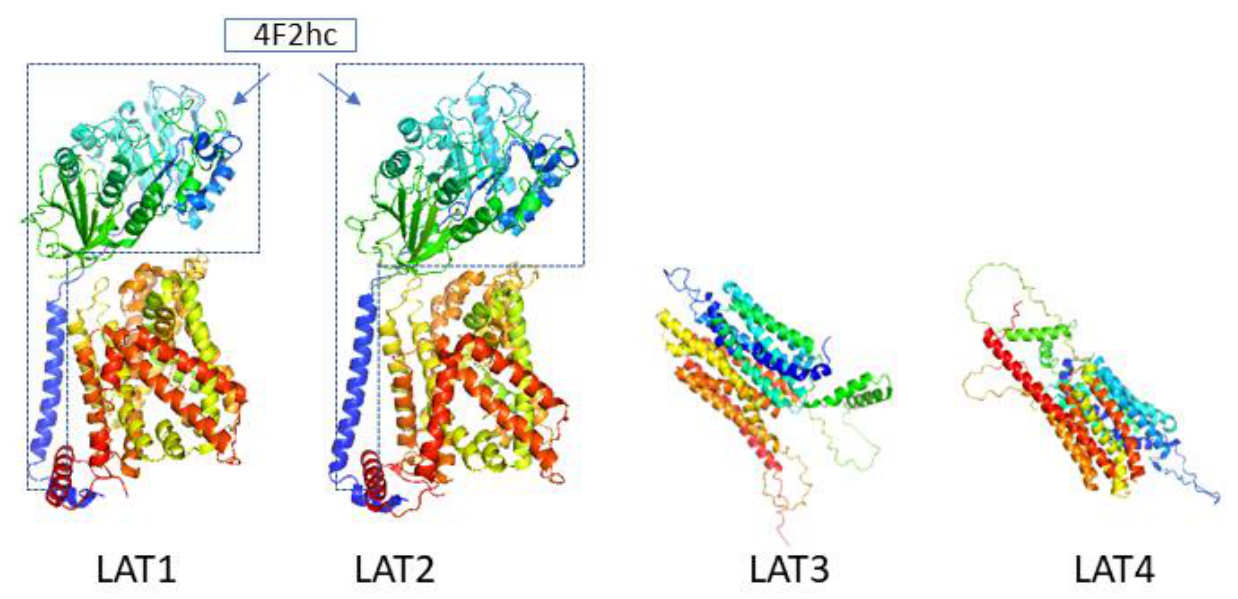
Figure 2. The three-dimensional conformation of LATs. Both LAT1 and LAT2 consist of 12 trans- membrane domains that form pathways for their substrates. They bind to the heavy glycoprotein subunit 4F2hc via disulfide bonds. Unlike LAT1 and LAT2, the biological functions of LAT3 and LAT4 do not require binding to heavy chains and can exist independently. (Images created using PyMol*, colord by chainbows, the PDB ID: 6IRS, 7CMI, the Uniprot ID: O75387, Q8N370, PyMol* (version 2.5 Schrodinger. Warren L. DeLano), and RCSB PDB, and UniProt).